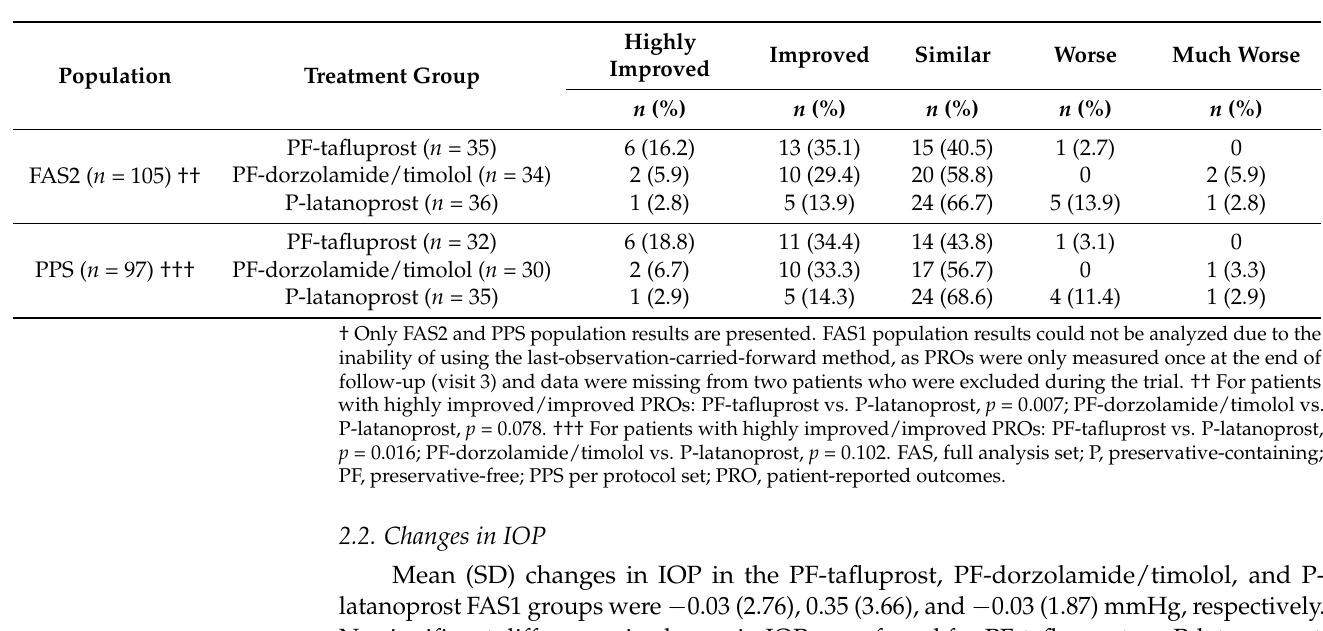
Table 4. Patient-reported treatment satisfaction in the FAS2 and PPS populations